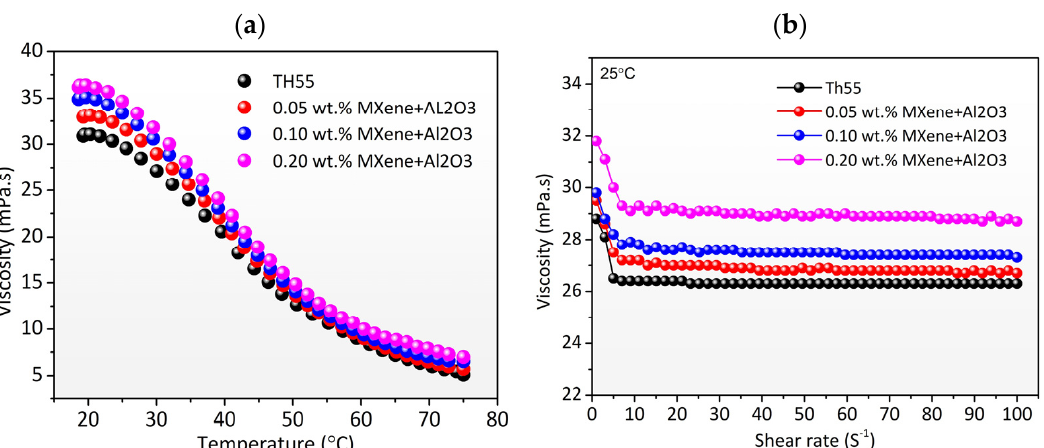
Figure 8. Dynamic viscosity as a function of: ( a ) temperature and, ( b ) shear rate or TH55 base fluid and TH55/ MXene + Al 2 O 3 nanofluid at different concentrations.